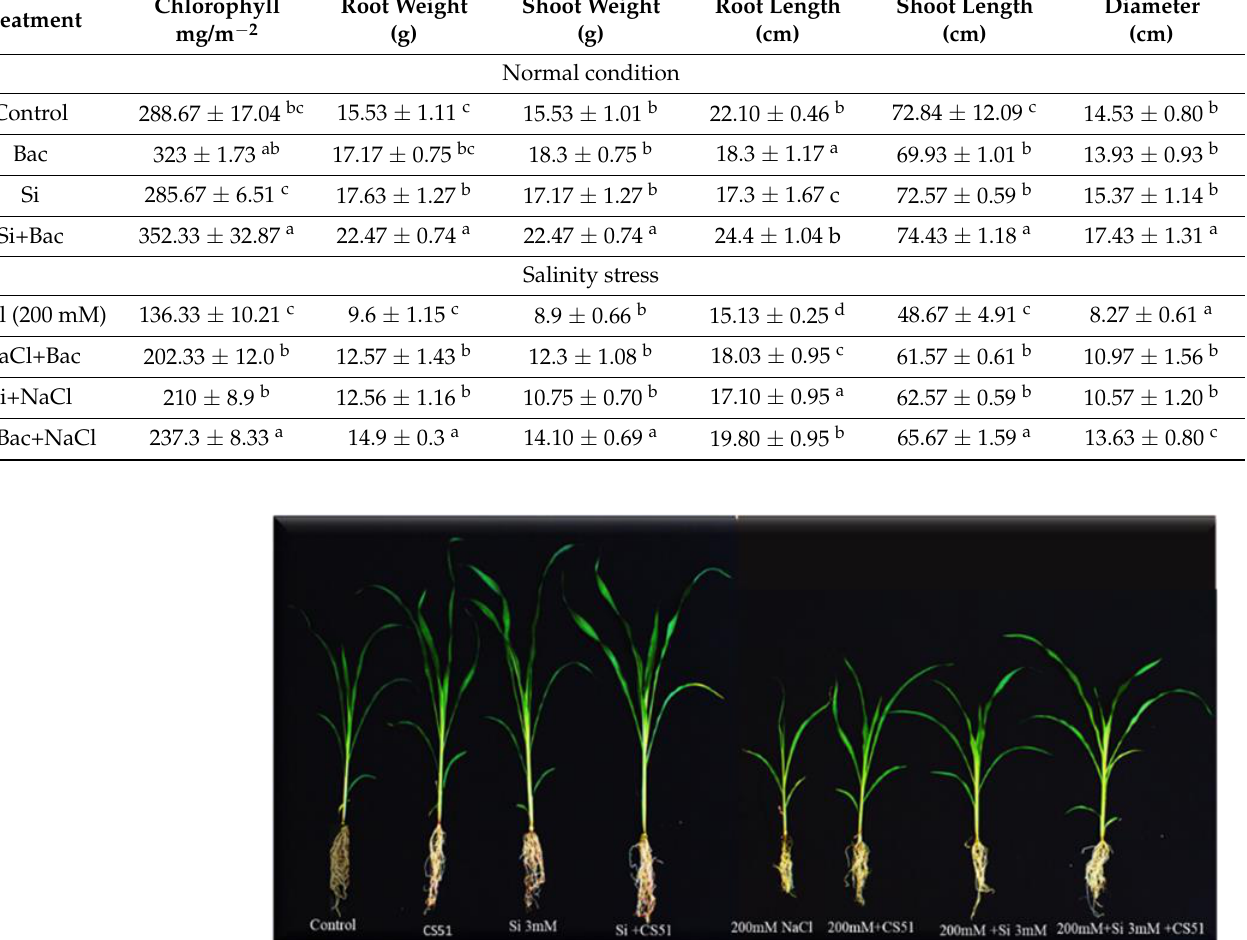
Figure 3. Effects of selected rhizospheric and endophytic bacterial isolate on maize plant growth attributes under NaCl concentration (200 mM). Table 1. The effect of isolate CS51, Si, and co-application of isolate CS51+Si on the growth, biomass, and chlorophyll con- tent of maize plants under normal and NaCl stress (200 mM). Each value represents the mean ± SD of three replicates. Values in a column followed by different letters are significantly different as evaluated by Duncan’s Multiple Range Test (DMRT).